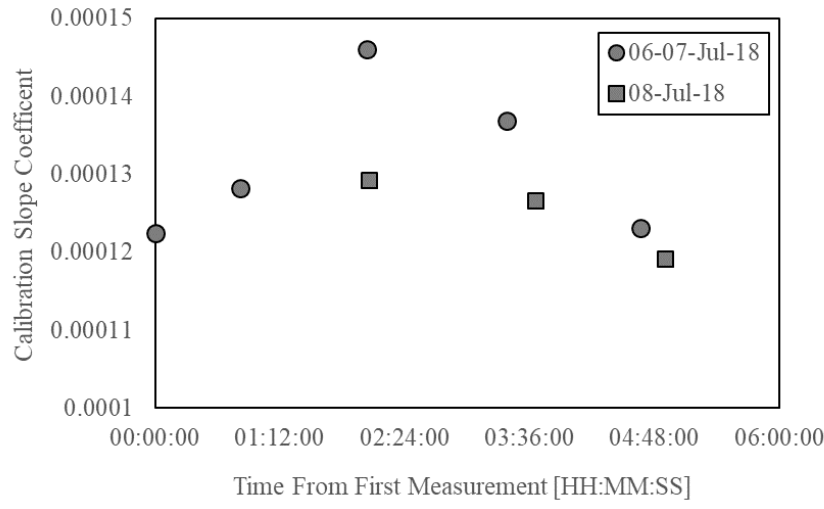
Figure 4. Example calibration slope coefficients (derived from regressions of gas cell concentrations against apparent absorbance) from two days of data. Timings are from the time of the first calibration on each of these measurement days. Note that the coefficient peaks towards solar noon.